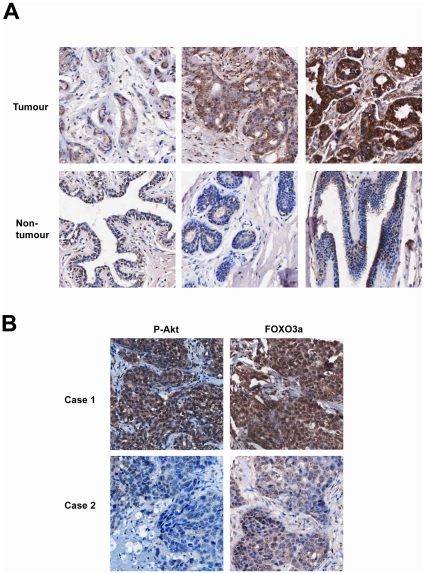
Representative expression patterns of FOXO3a and P-Akt in tissue microarray.Tumour tissue samples obtained from breast cancer patients that had been formalin-fixed and paraffin-embedded were immunohistochemically stained with FOXO3a and P-Akt (Thr308) antibodies using the streptavidin-biotin-peroxidase technique. A) Representative FOXO3a staining patterns in both tumour and non-tumour cases (magnification ×170). B) Two representative tumour cases showing corresponding FOXO3a and P-Akt staining patterns (magnification ×170). Case 1 shows high cytoplasmic pAkt staining and strong cytoplasmic and nucleus FOXO3a staining. Case 2 shows weak pAkt and FOXO3a staining.